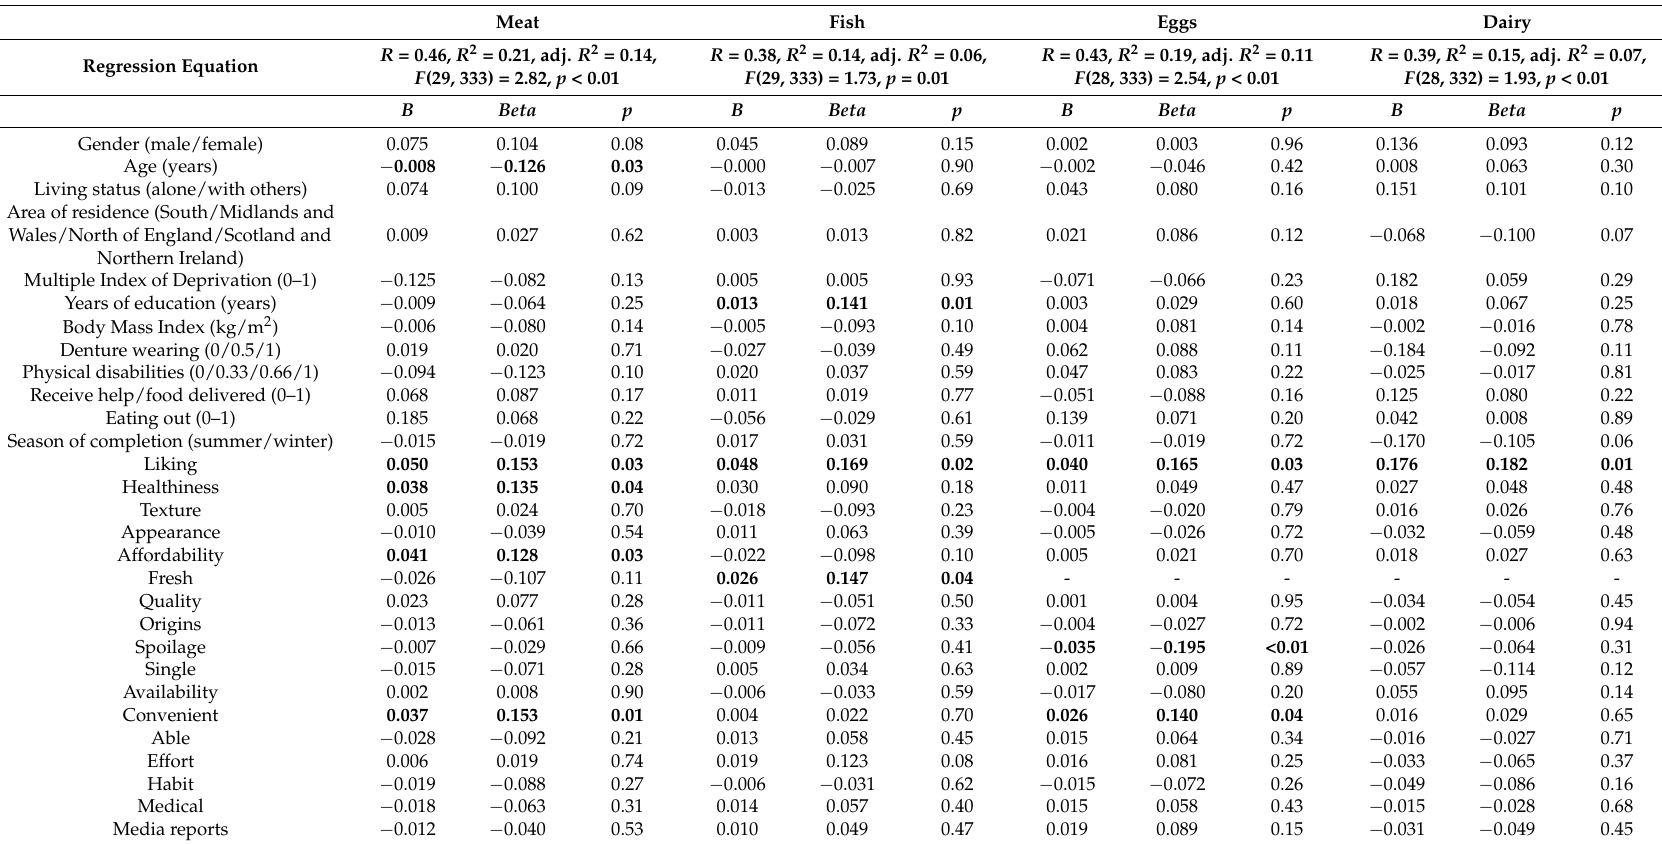
Table 3. Outcomes of the regression analyses investigating the impact of demographic and lifestyle characteristics and each of the barriers and facilitators for each food group studied. Meat Fish Eggs Dairy Regression Equation